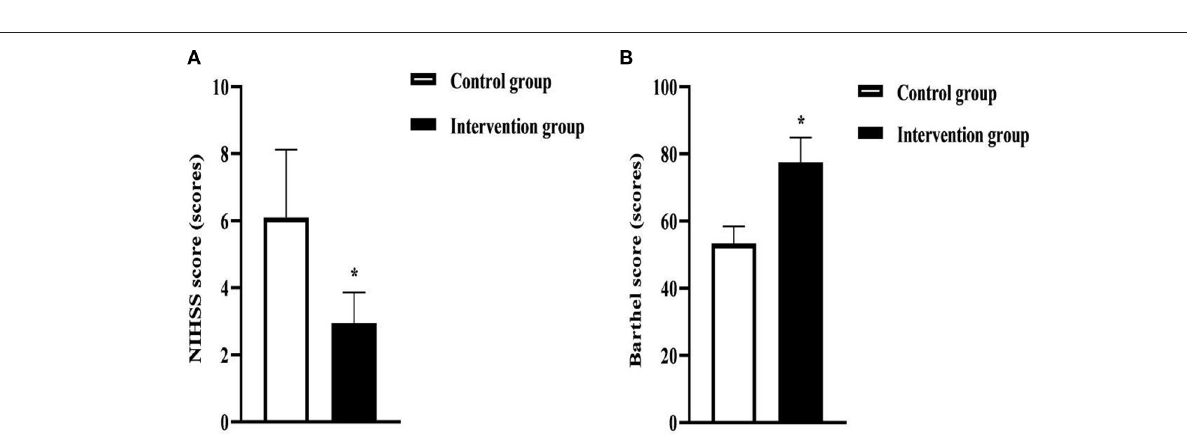
departments, and solves the problems of message lag, repeated information collection, tedious verification work, and poor communication between doctors, nurses, and patients among